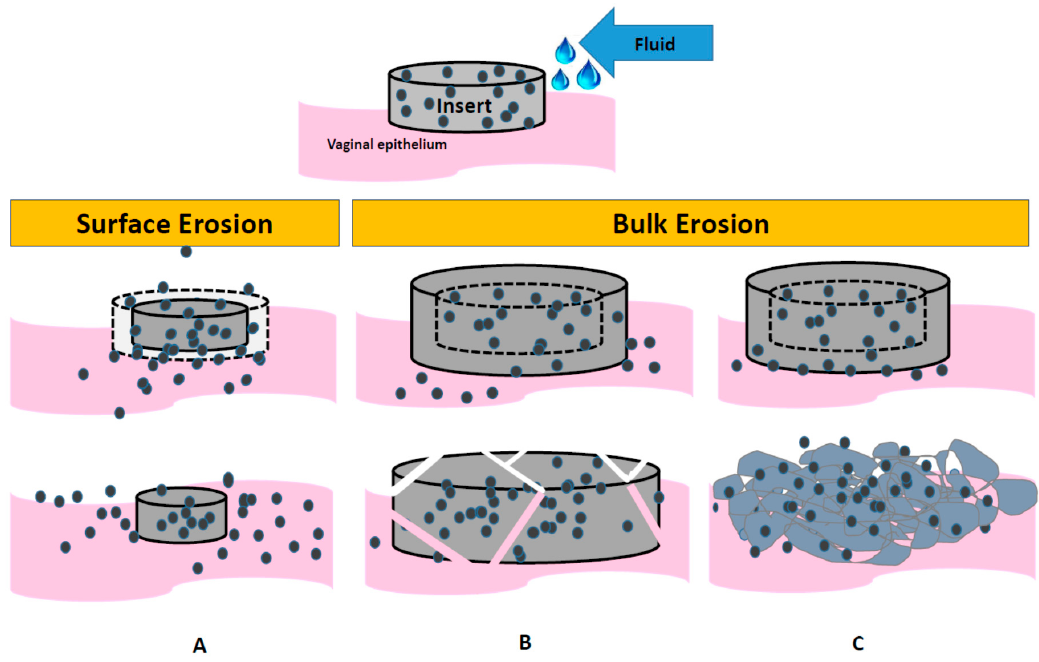
Figure 2. Schematic of the different processes of topical insert disintegration with the introduction of vaginal fluid. Surface erosion: ( A ) The size of the insert decreases as the surface disintegrates releasing drug. Bulk erosion: The size of the insert first increases due to fluid uptake and swelling, followed by ( B ) breakdown of the insert into smaller pieces until fully disintegrated or ( C ) transformation from the solid state into a gel.